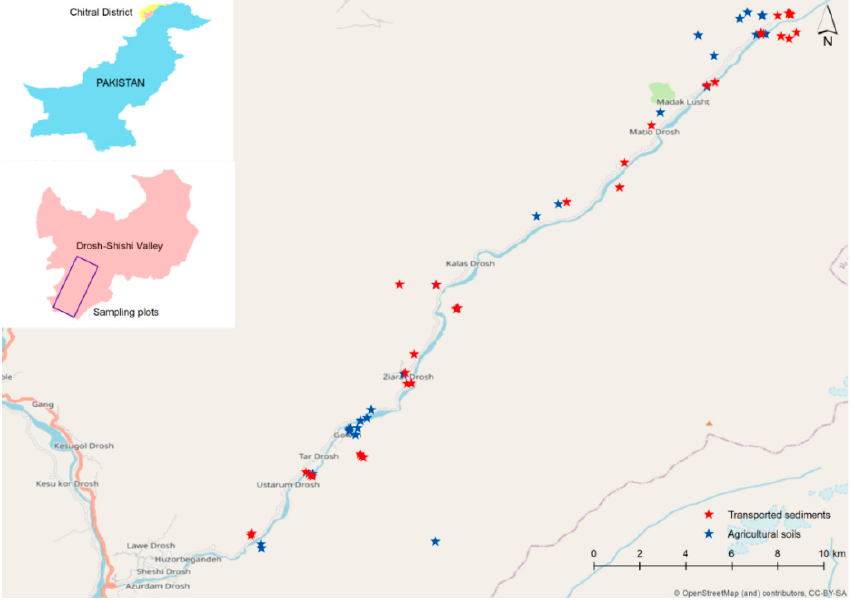
Figure 1. Map of study area showing location of sampling